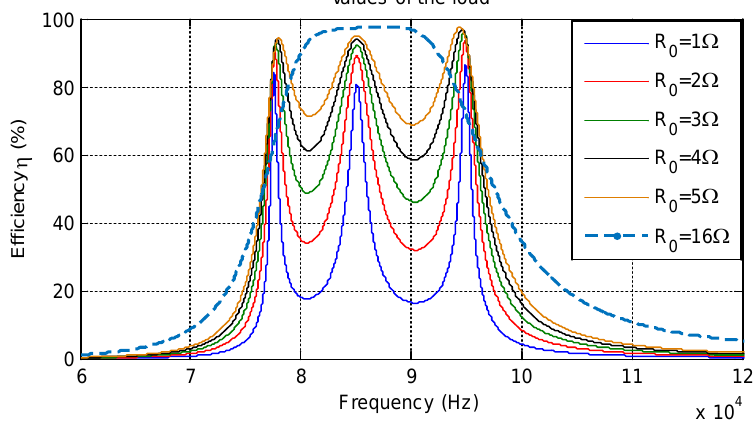
Figure 10. Evolution of the efficiency as a function of the frequency for different loads.